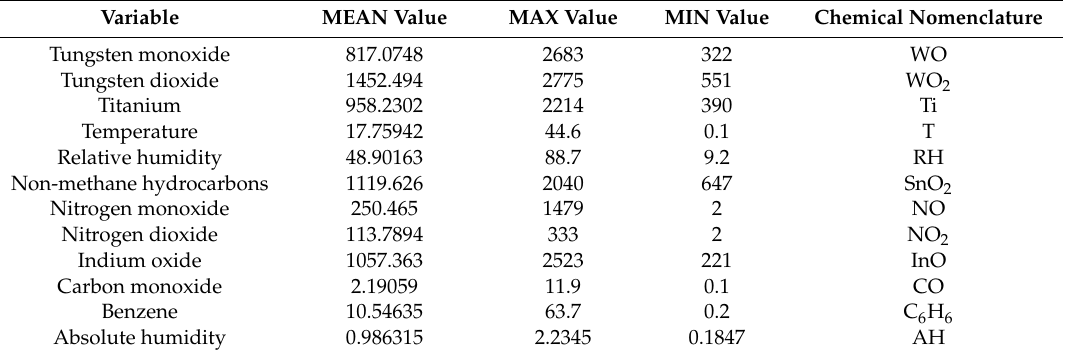
Table 2. The main characteristics of the Internet of Things (IoT)-based